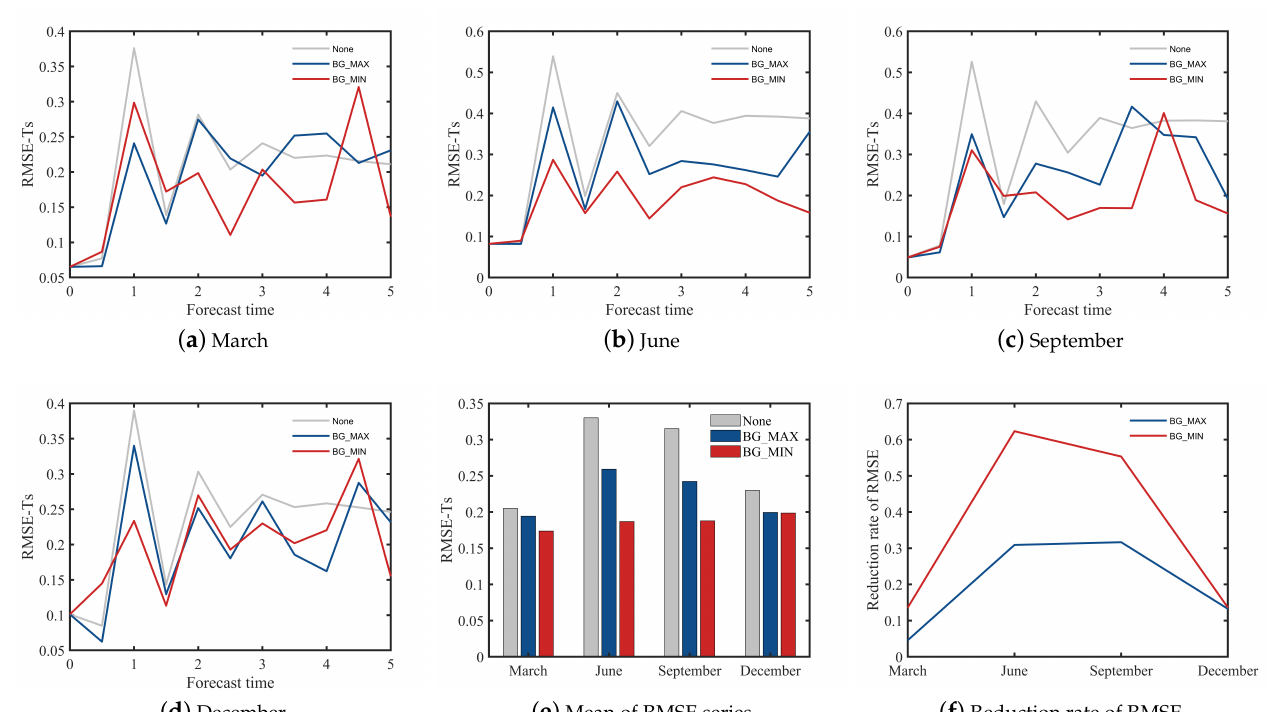
Figure 3. Comparison of analysis accuracy after introducing samples in BG_MAX and BG_MIN with obs_err = 10 − 0.5